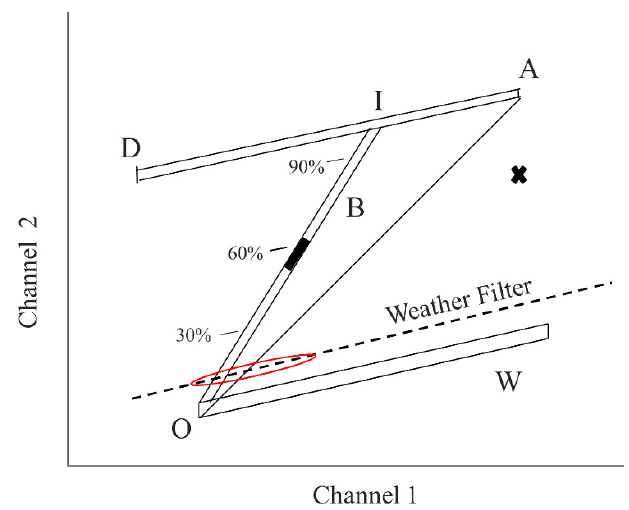
Figure 2. Schematic diagram of the bootstrap algorithm.